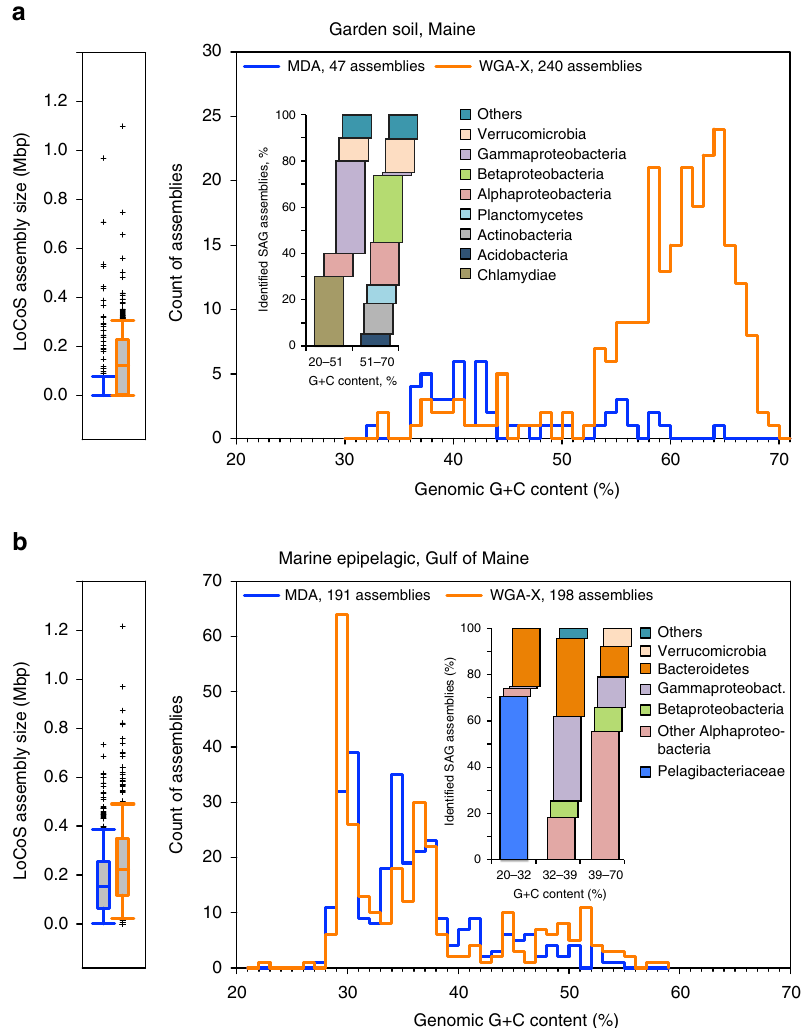
Fig. 3 Results of low-coverage sequencing ( LoCoS ) of WGA-X and MDA SAGs of prokaryotes from a garden soil and b coastal ocean. Presented are de novo assembly sizes, G+C content, and phylogenomic assignments. A total of 317 SAGs were generated from each environment using each gDNA ampli fi cation method. The count of successful SAG assemblies is provided next to the gDNA ampli fi cation method. Insets indicate the phylogenomic assignments of SAGs within discernable G+C